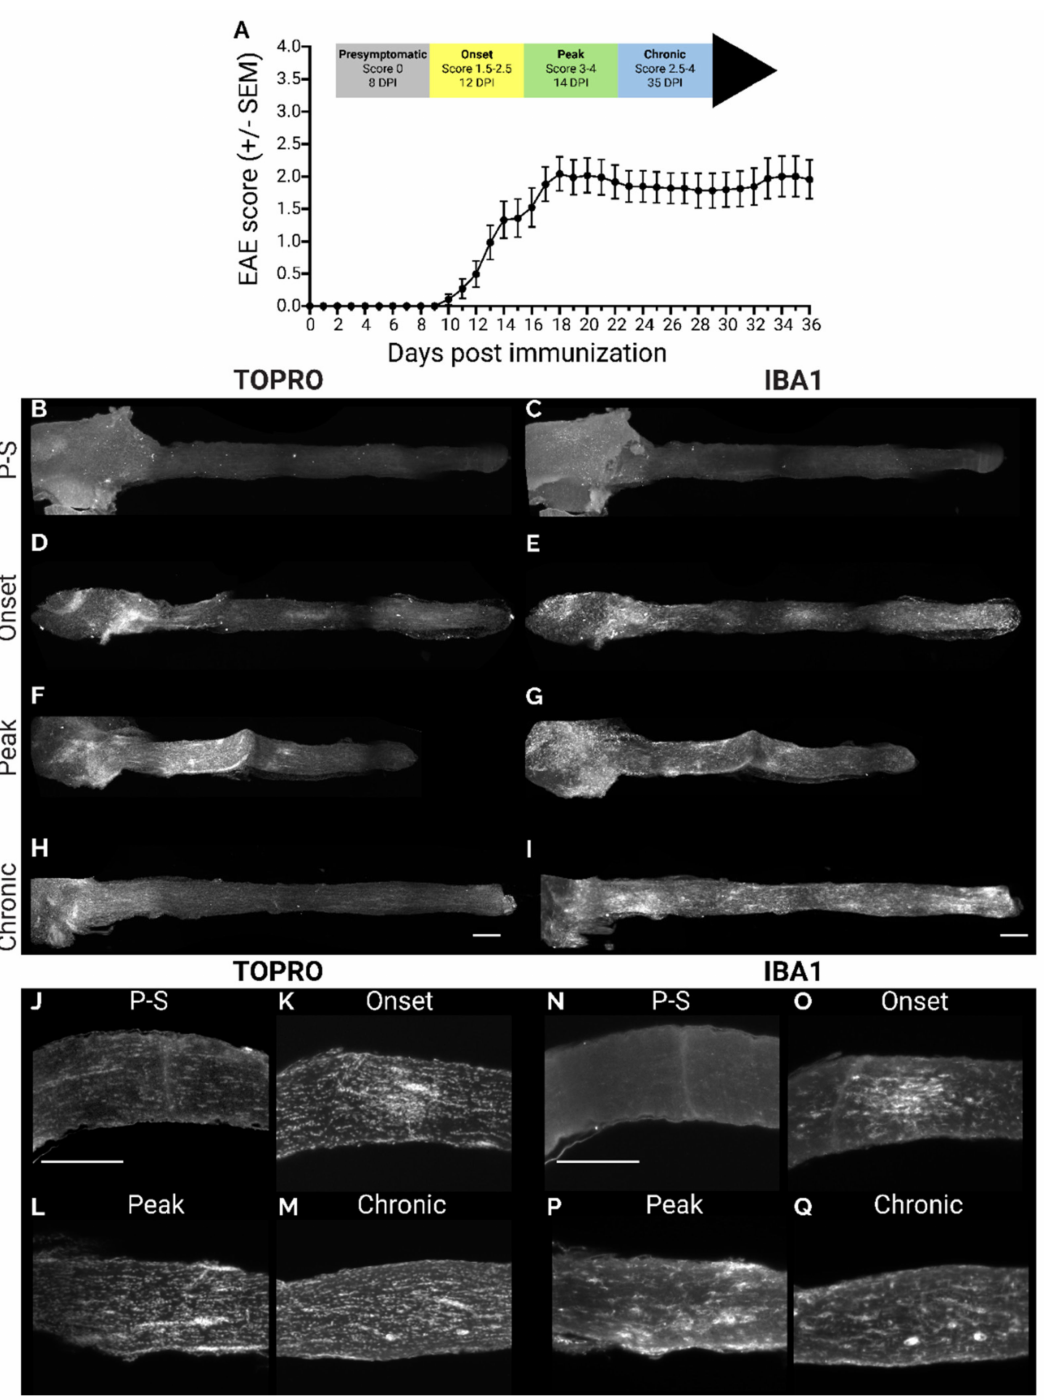
Figure 2. 3D imaging of optic nerve inflammation in EAE. ( A ) EAE cohort score progression. ( B – I ) Representative max projection of straightened optic nerves labelled with Topro ( B , D , F , H ) or Iba1 ( C , E , G , I ) from pre-symptomatic; P-S ( B , C ), onset ( D , E ), peak ( F , G ), and chronic ( H , I ) stages of EAE. Single optical sections from Topro ( J – M ) or Iba1 ( N – Q ) labelled optic nerves in pre-symptomatic; P-S ( J , N ), onset ( K , O ), peak ( L , P ), and chronic ( M , Q ) stages of EAE. Scale bars = 500 µ